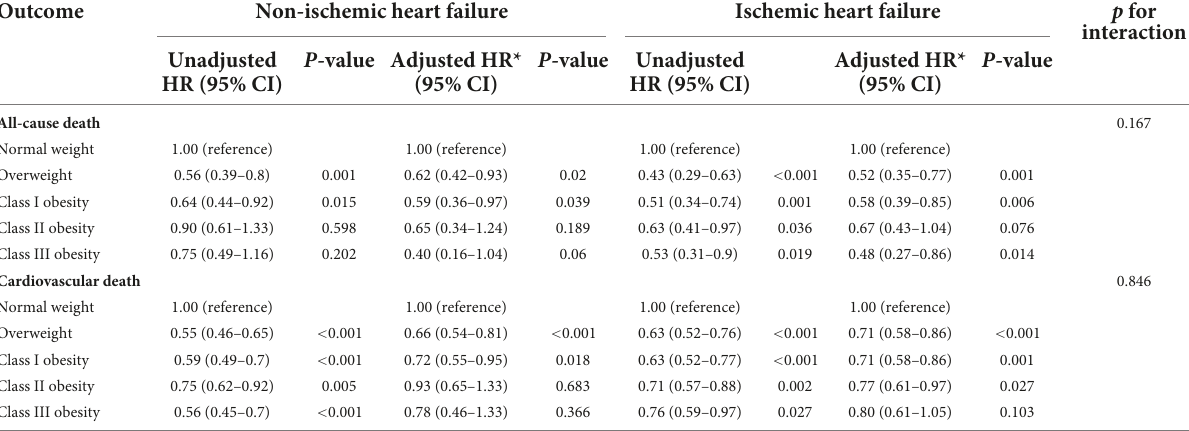
TABLE 3 Association between time-updated BMI category and short-term death according to heart failure etiology. Outcome Non-ischemic heart failure Ischemic heart failure p for